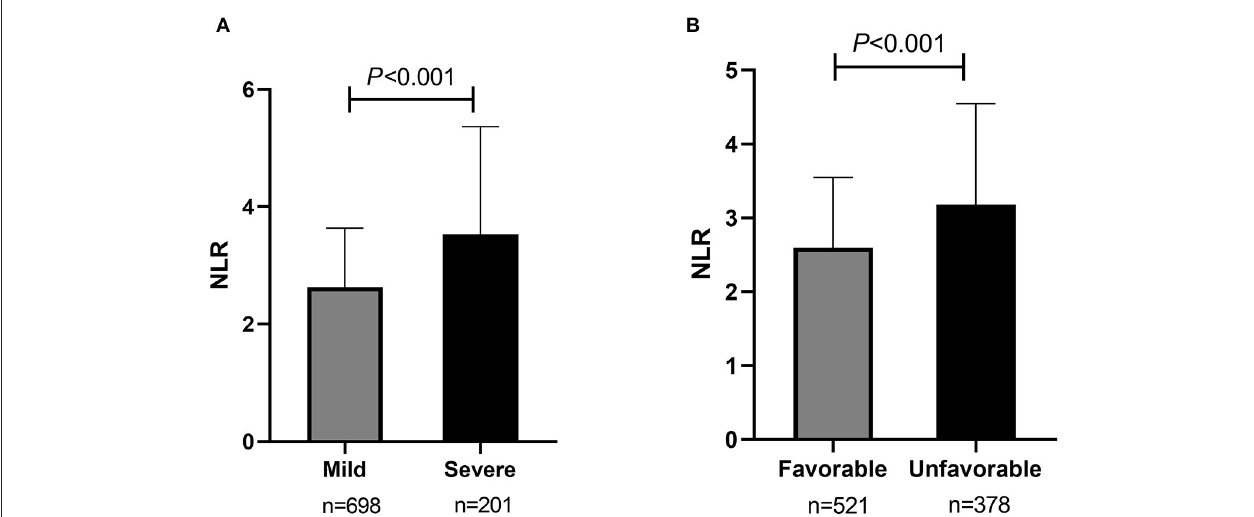
FIGURE 3 | Comparisons of admission NLR levels according to the initial stroke severity and short-term prognosis of sICAS. (A) Comparison of admission NLR levels according to the initial stroke severity (severe stroke vs. mild controls). (B) Comparison of admission NLR levels according to the short-term prognosis (unfavorable outcome vs. favorable outcome). NLR, neutrophil-to-lymphocyte ratio; sICAS, symptomatic intracranial atherosclerotic stenosis.